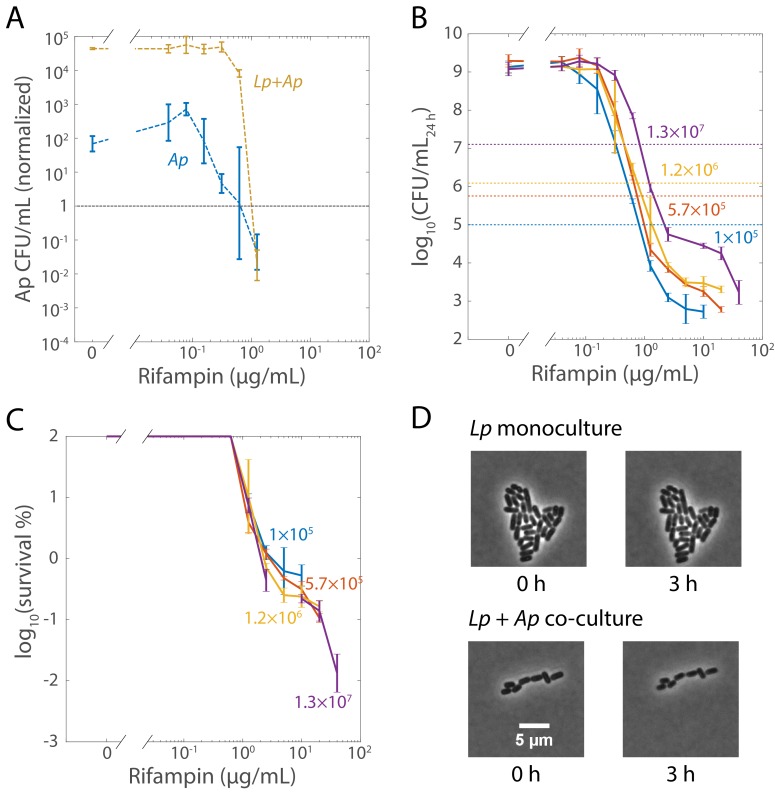
Changes in the survivability of Lactobacillus plantarum (Lp) when co-cultured with Acetobacter pasteurianus (Ap) are not due to increased survivability of Ap, inoculum size, or Lp growth in rifampin.(A) Ap has similar MICs in monoculture and in co-culture with Lp, and dies at supraMIC concentrations. Viable cell plating counts of Ap after growth in rifampin for 48 h were normalized to counts at the start of the experiment (t = 0, 5 × 105 and 1.3 × 105 CFU/mL in monoculture and co-culture, respectively) to highlight the concentration at which growth is completely inhibited. Note that the monoculture experiences partial growth inhibition at a lower concentration than the co-culture, and that in the absence of antibiotic, Ap grows more in co-culture with Lp than as a monoculture. Error bars are standard deviation (S.D.) for each condition, n = 3. The highest concentration of rifampin tested was 40 µg/mL. b) Inoculum size did not change the MIC of rifampin in Lp monocultures. Viable cell plating counts of Lp after growth in rifampin for 48 h were determined from different initial cell densities (numbers in colors, CFU/mL at t = 0). Error bars are S.D. for each condition, n = 3. (C) Inoculum size did not change the survivability of Lp to supraMIC concentrations of rifampin. Viable cell plating counts of Lp after growth in rifampin for 48 h were normalized to the initial cell density (t = 0), same data as in (B). Error bars are S.D. for each condition, n = 3. (D) Single-cell imaging demonstrated that Ap-induced tolerance of Lp was not due to growth under rifampin treatment. Representative phase-microscopy images of Lp in monoculture and co-cultured with Ap on an MRS agar pad containing 50 µg/mL rifampin.